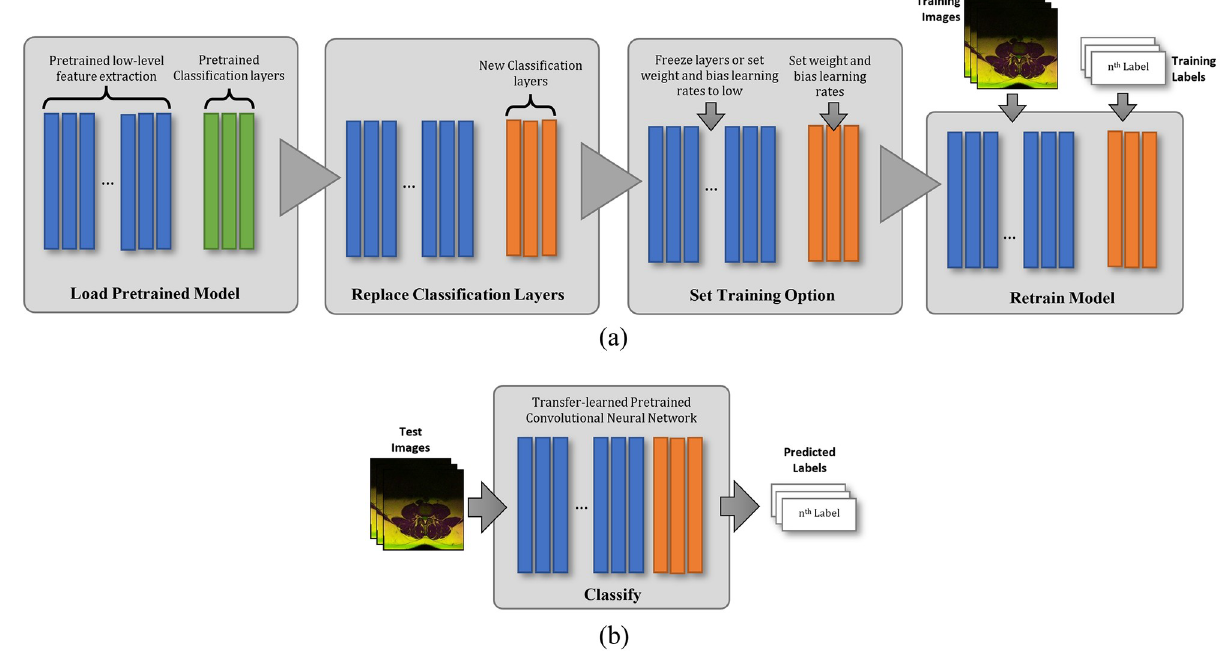
Fig 4. A flowchart describing the traditional Transfer Learning approach of using Deep Convolutional Neural Network for medical image classification, where a) depicts the training process and b) depicts the inference step.